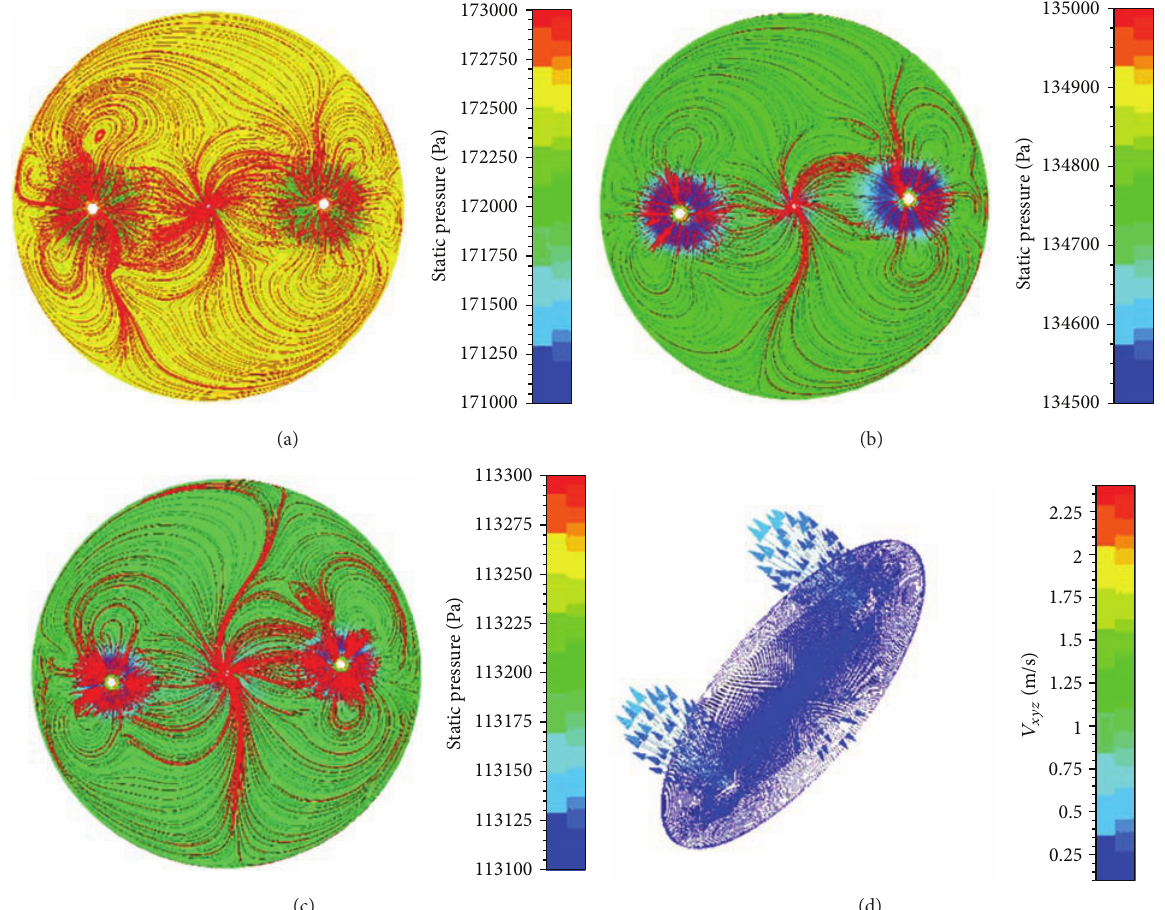
Figure 9: The simulation results in large flow: (a) the middle surface streamline chart in inlet static pressure of 200,000 Pa, (b) the middle surface streamline chart in inlet static pressure of 150,000 Pa, (c) the middle surface streamline chart in inlet static pressure of 120,000 Pa, (d) the middle surface vector of cavity in inlet static pressure of 150,000Pa.